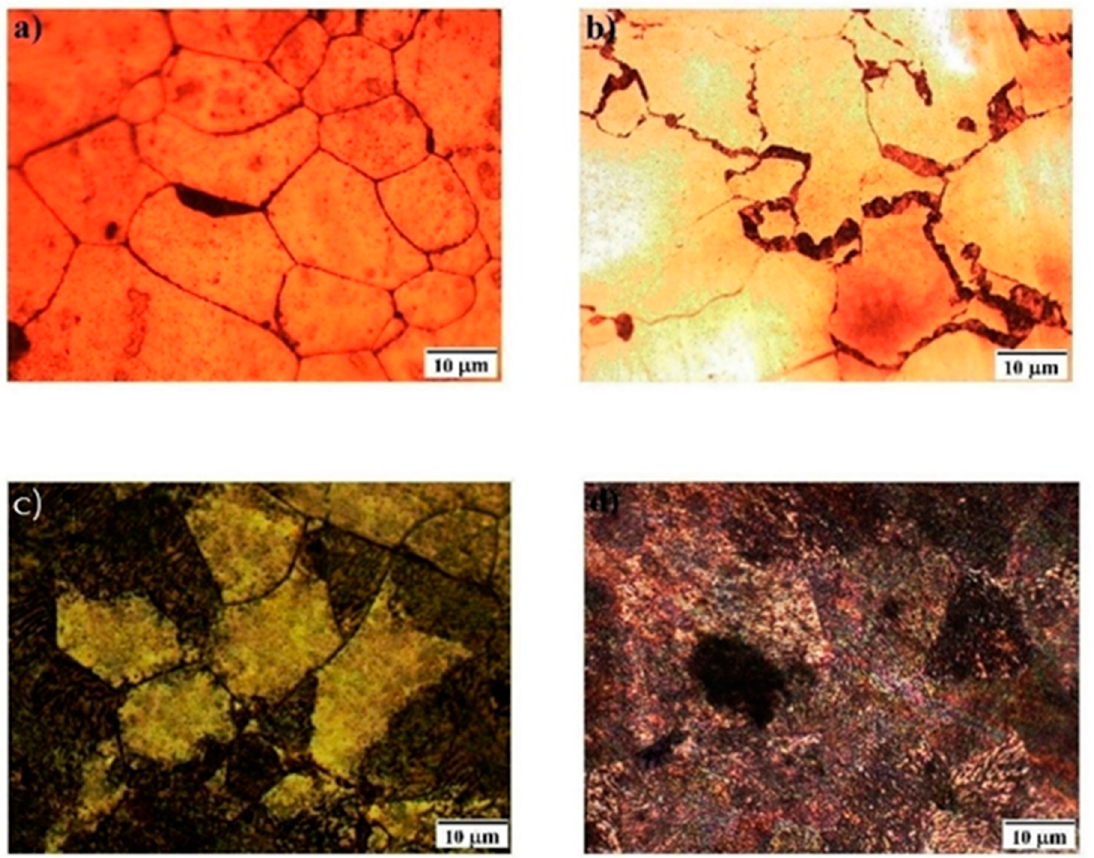
Figure 6. Optical micrographs of AZ91 alloy aged at 150 °C for a ) 4 h, b ) 24 h, c ) 96 h, and d ) 192 h.